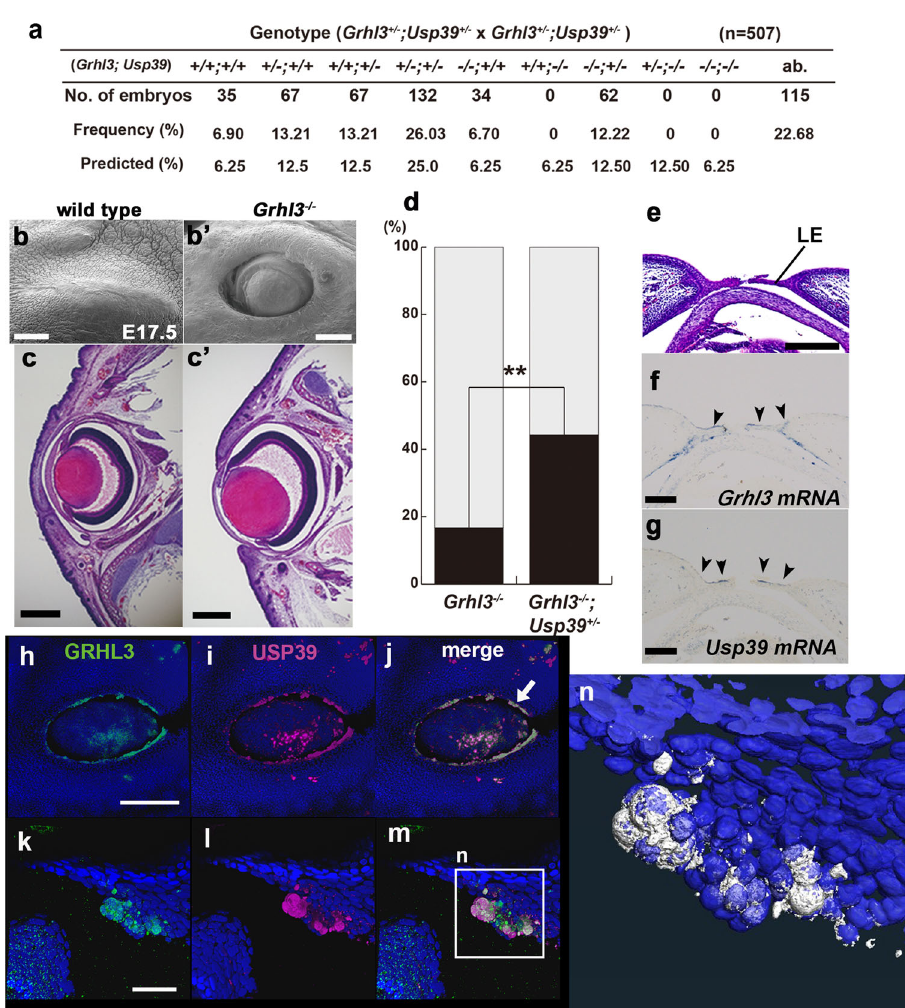
Fig. 7 Usp39 genetically interacts with Grhl3 in epithelial morphogenesis during eyelid closure. a Frequencies of genotypes among embryos from crossing Grhl3 + / − ; Usp39 + / − with Grhl3 + / − ; Usp39 + / − mutant mice at E18.5. Usp39 − / − embryos, such as Usp39 − / − , Usp39 − / − ; Grhl3 + / − , and Usp39 − / − ; Grhl3 − / − embryos, were not observed at E18.5. b , b ′ Scanning electron micrographs of E17.5 eyelids from wild-type ( b ) and Grhl3 − / − ( b ′ ) fetuses. The eyelid is closed in the wild-type embryo at E17.5 ( b ). The eyelid is still open in the Grhl3 − / − fetus at E17.5 ( b ′ ). c , c ′ Hematoxylin and eosin staining of an eyelid from wild-type ( c ) and Grhl3 − / − ( c ′ ) embryos at E17.5. d Penetrance of the open-eye phenotype in Grhl3 − / − ( N = 60) and Grhl3 − / − ; Usp39 + / − ( N = 70) embryos. ** p < 0.01 ( χ 2 test). e Hematoxylin and eosin staining from a wild-type embryo at E15.5. f , g Grhl3 and Usp39 mRNA expression in the eyelid region. Grhl3 transcripts were highly expressed in the epithelium of the leading edge at E15.5 ( f arrowheads). Usp39 transcripts were also detected in the dorsal leading-edge region at E15.5 ( g arrowheads). h – m Merged image of Grainyhead-like 3 (GRHL3; green) and ubiquitin-speci fi c protease 39 (USP39) proteins (magenta) demonstrating a large overlap ( j , m fl attened peridermal cells) eyelids of wild-type embryos at E15.5. n Reconstructed three- dimensional-confocal images of overlapped USP39 and GRHL3 protein expression [white] in the panel m using Amira 6.2.0 software. Scale bars